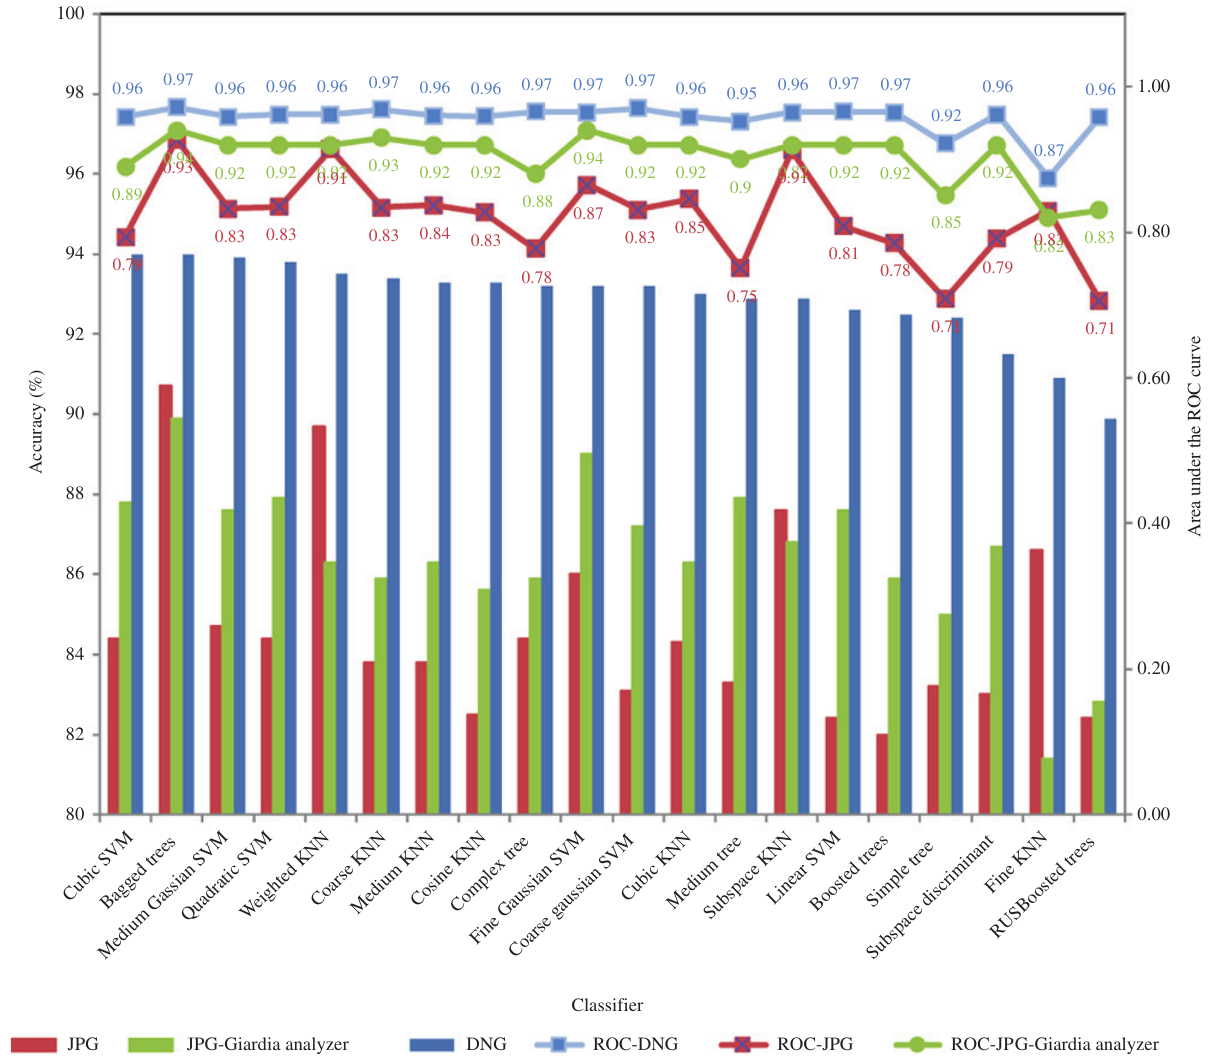
Figure 4: The effect of the image file format on the classification accuracy and specificity of various classifier models. DNG images resulted in much better classification accuracy compared to other file